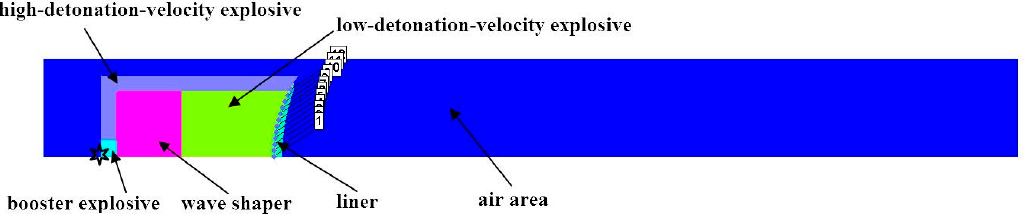
Figure 2. Finite-element numerical calculation model.